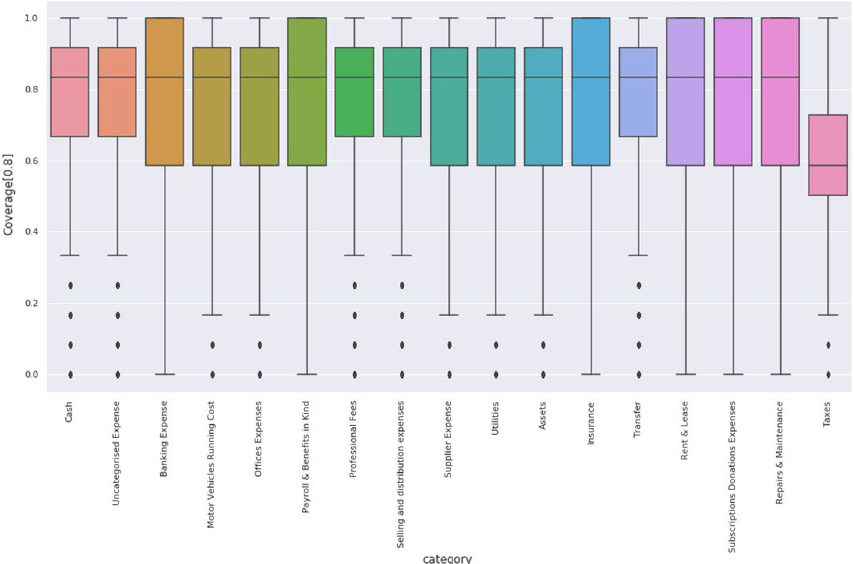
taxes category seem to